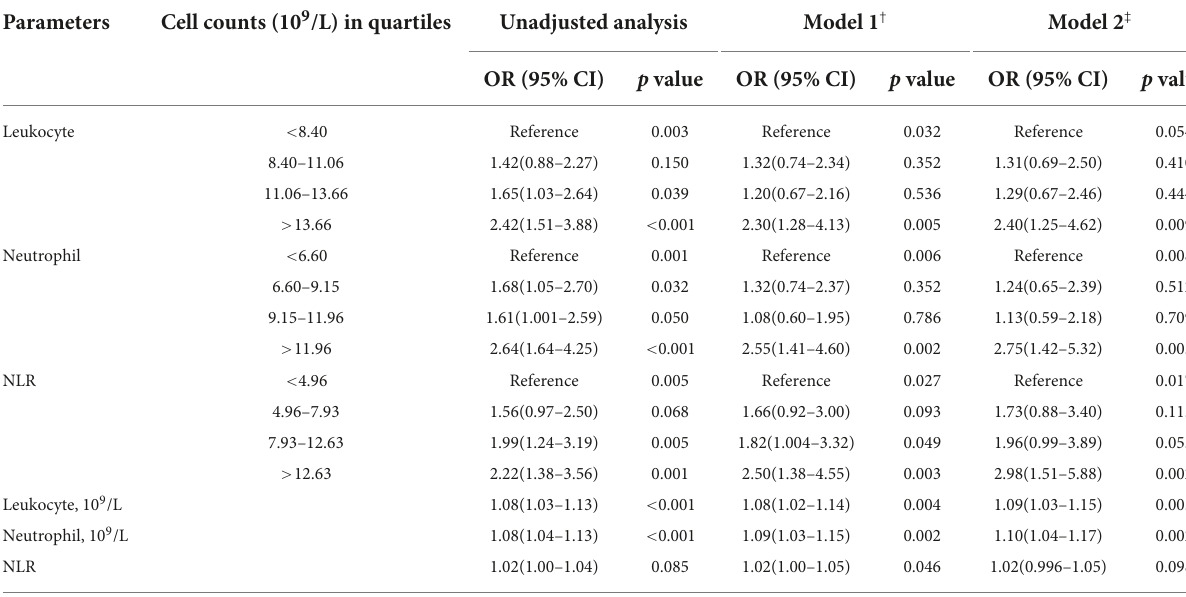
TABLE 4 Unadjusted and adjusted analyses of neutrophil count ( × 10 9 /L), leukocyte count ( × 10 9 /L), NLR with mortality at 90 days.